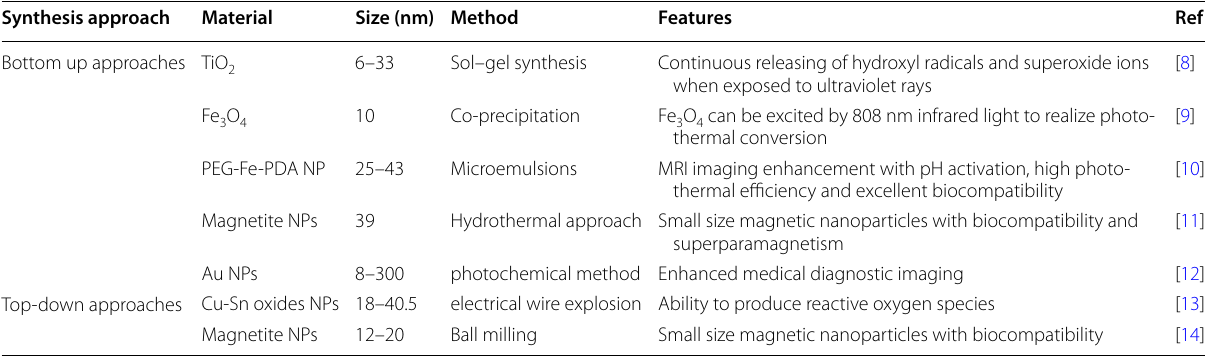
Top-down approaches Cu-Sn oxides NPs